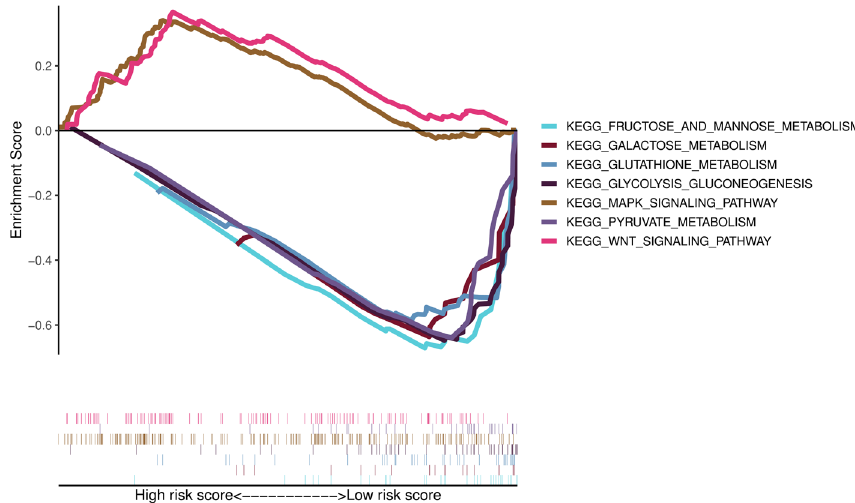
Figure 10. Gene set enrichment analysis (GSEA) based on KEGG pathway in different risk groups.